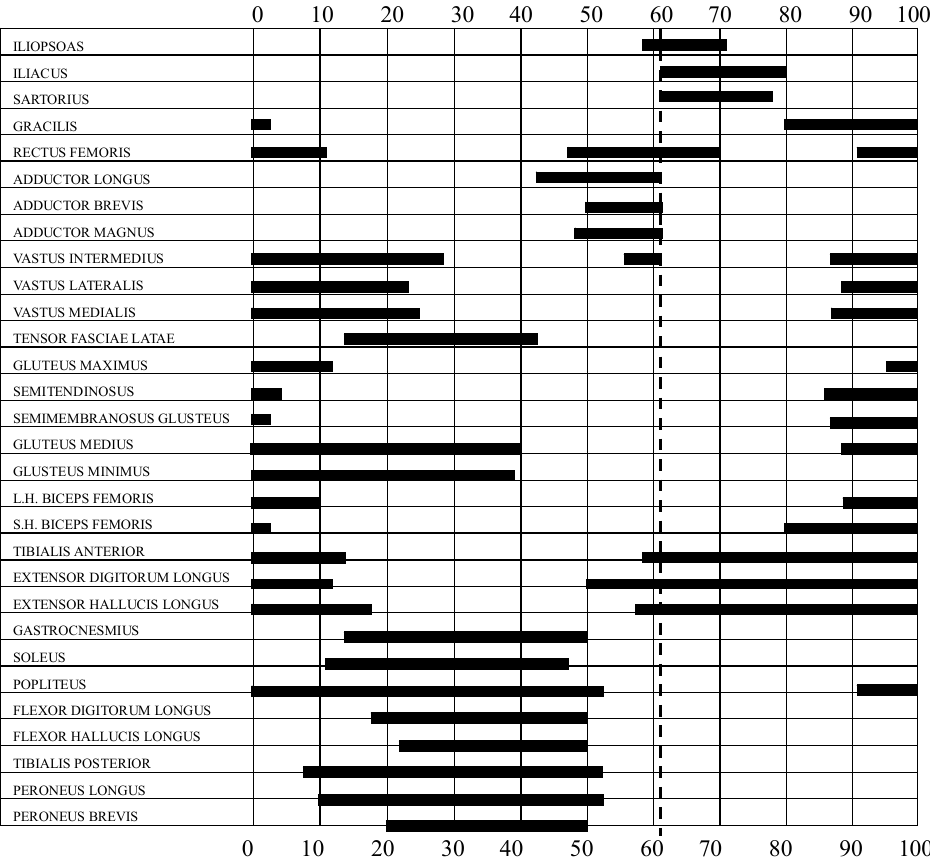
Figure 8. “On-off” diagrams of normal EMG activities during gait